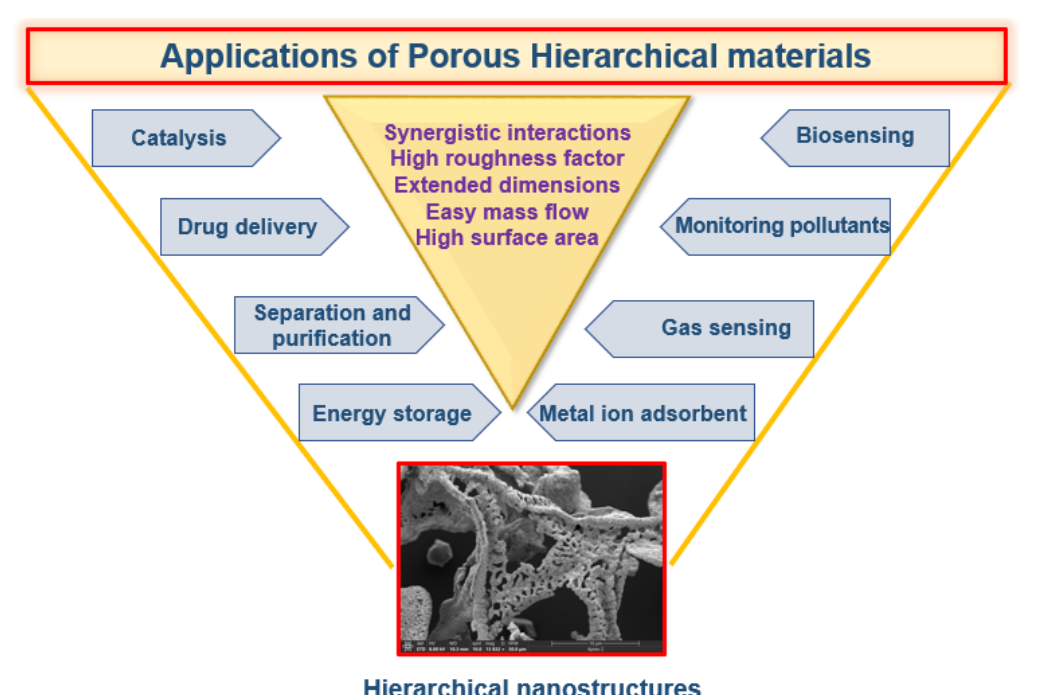
Figure 1. Schematic showing the wide-ranging areas involving the use of porous hierarchical mate- rials.